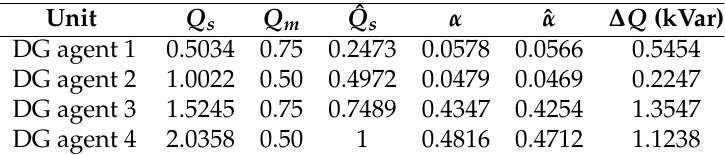
Table 2. The simulation results for Case